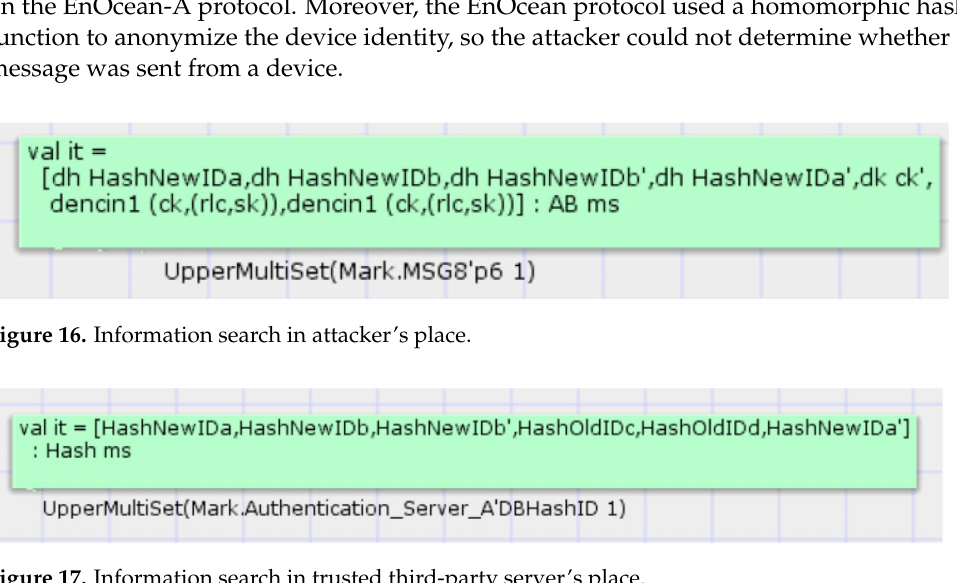
Figure 17. Information search in trusted third-party server’s